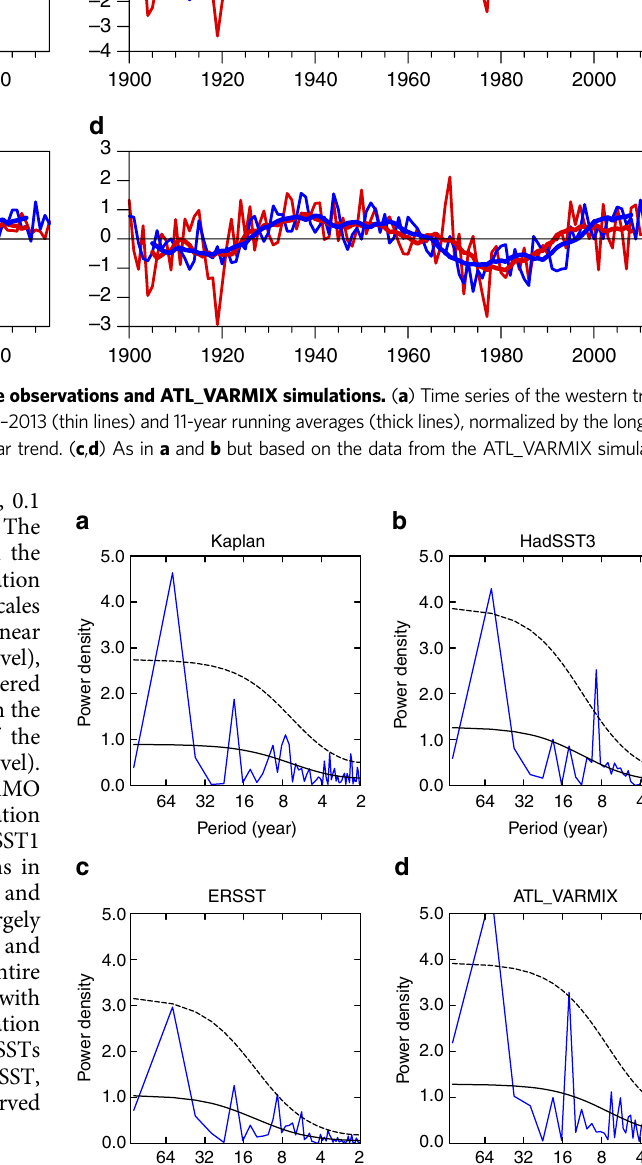
NATURE COMMUNICATIONS|8:15998|DOI: